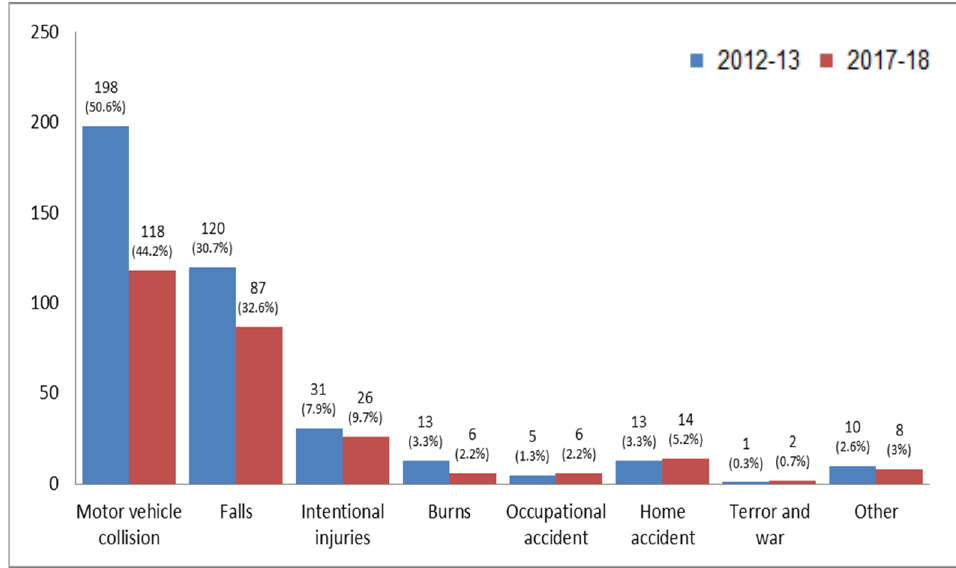
Figure 1. Type of trauma incident according to the years 2012–2013 and 2017–2018.